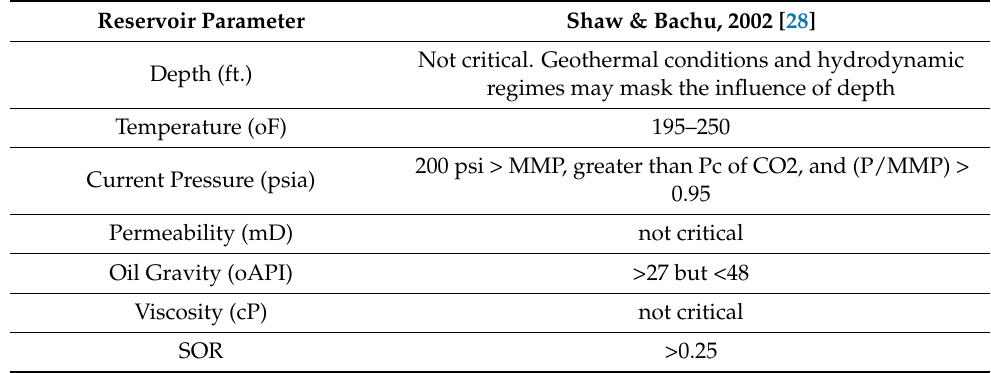
Table 6. Summary of CO 2 -flooding Screening Criteria Used in This Study Based on Six Reservoir Parameters from